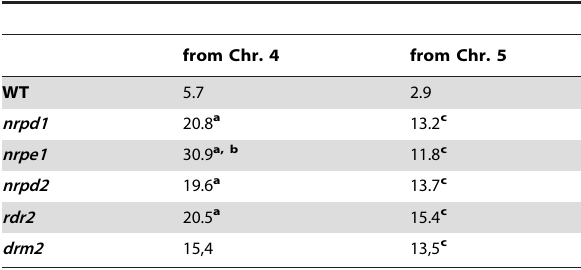
Table 1. Proportion of heterogenous 5S-210 transcripts (%) from chromosomes 4 and 5.